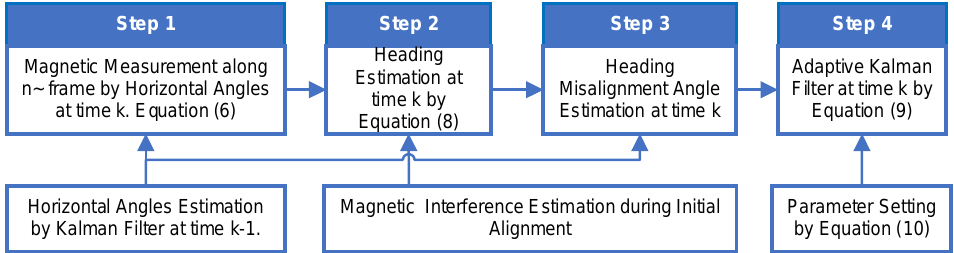
Figure 4. Adaptive Inertial/Magnetometer Positioning Algorithm.